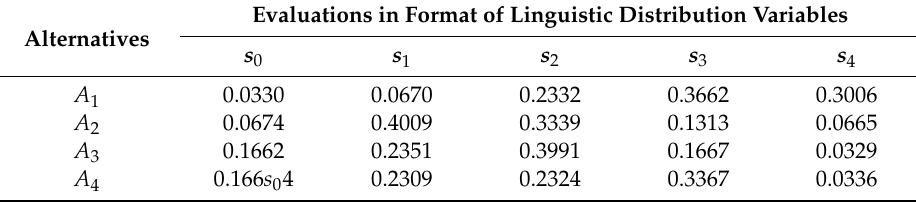
Table 2. The linguistic distribution evaluations on criterion C 2